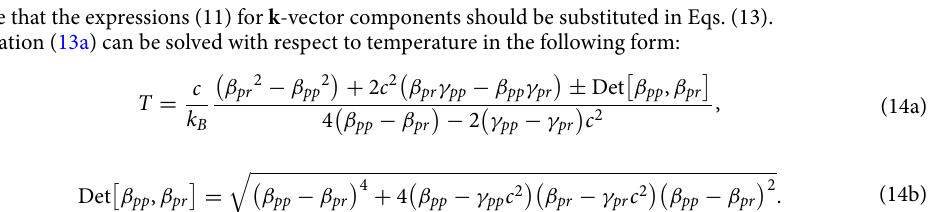
Note that the expressions (11) for k -vector components should be substituted in Eqs. (13). Equation (13a) can be solved with respect to temperature in the following form: